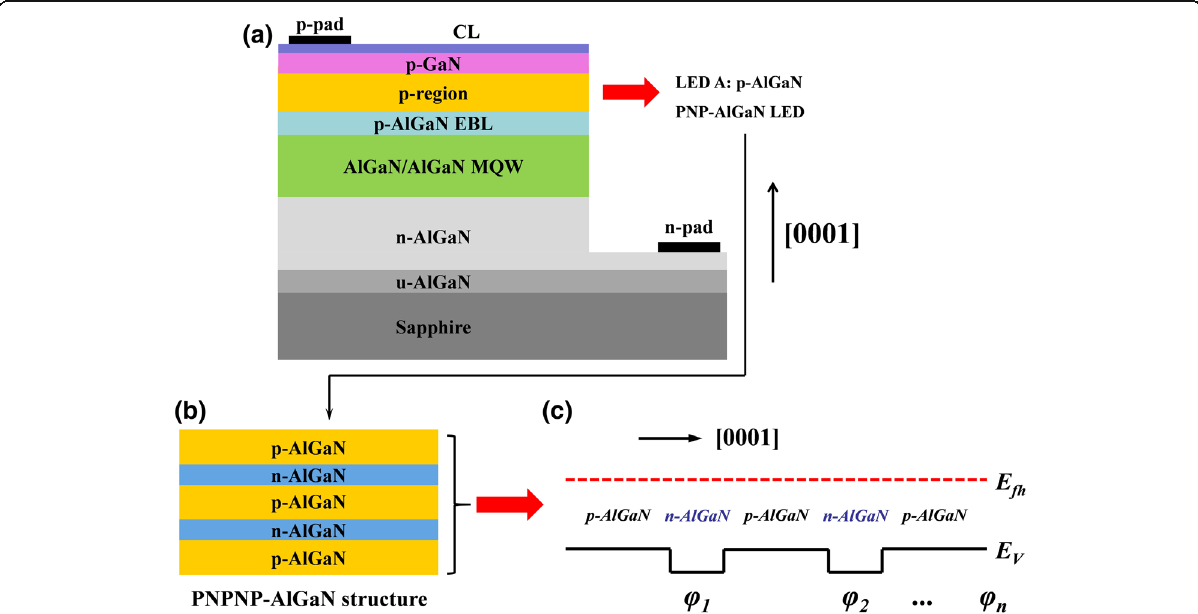
Fig. 1 a Schematic diagrams for the studied devices (reference LED A and PNPNP-AlGaN LED), b schematic diagrams for the PNP-AlGaN structure with two PNP-AlGaN junctions, c schematic valence band diagram for the PNP-AlGaN structure with multiple PNP-AlGaN junctions, in which φ 1 , φ φ n denote the barrier height for each PNP-AlGaN junction along the [0001] orientation and n represents the PNP-AlGaN junction 2 , and